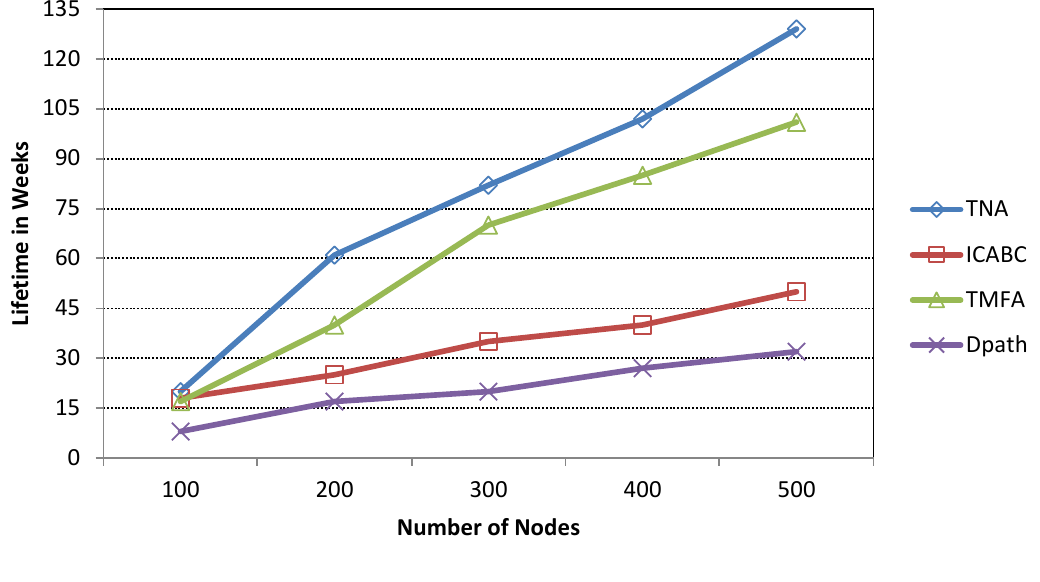
Figure 5. Comparison of network lifetime versus number of